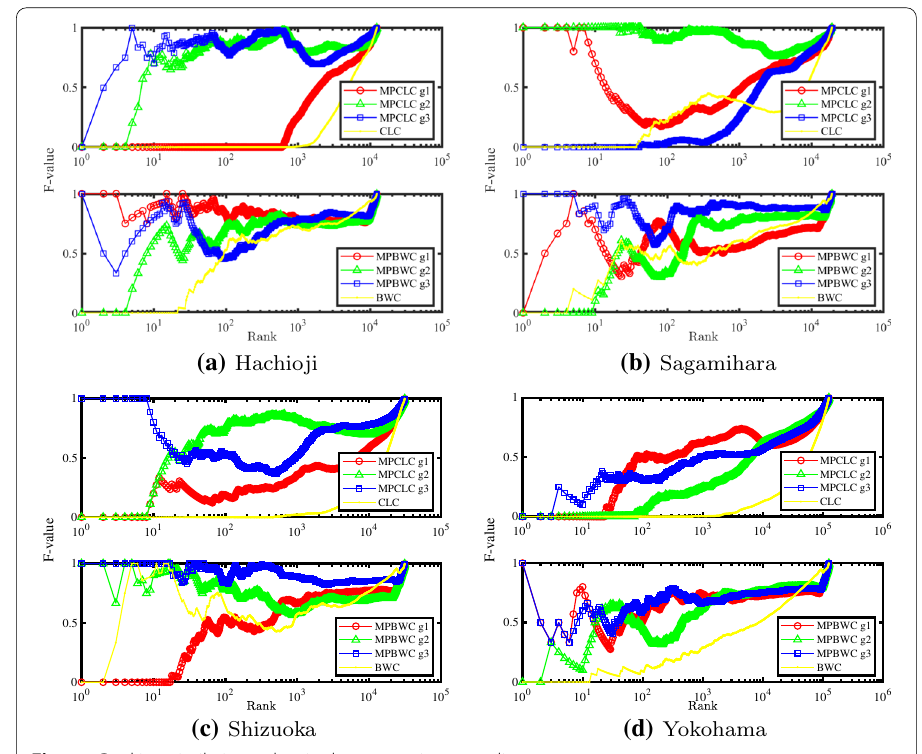
Fig. 11 Ranking-similarity to the single perspective